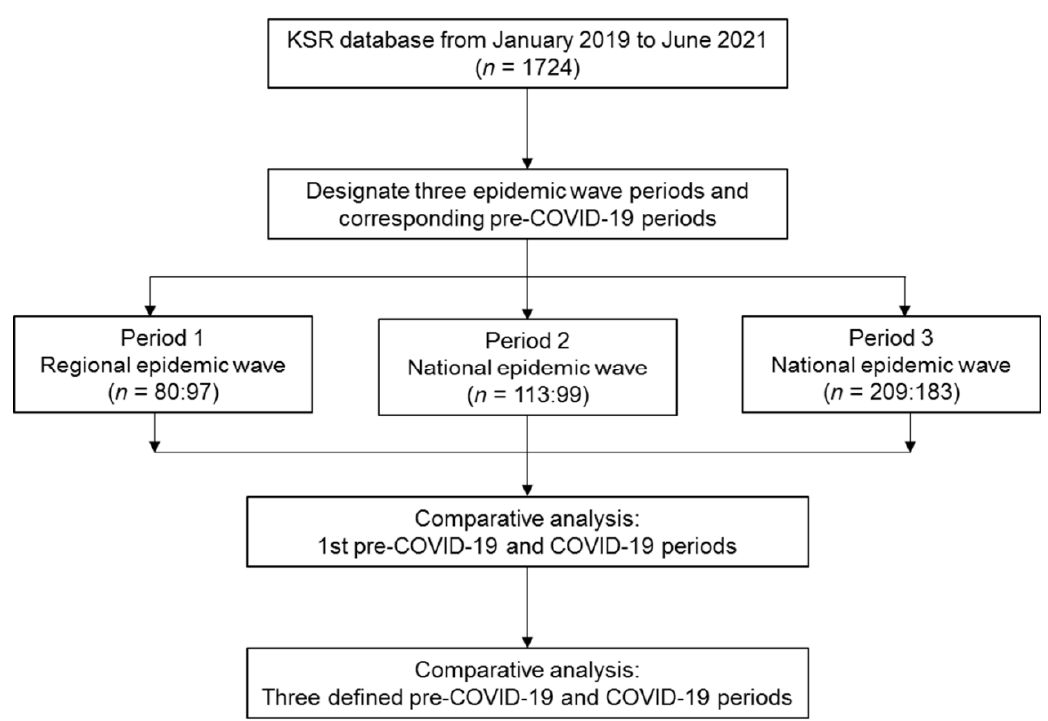
Figure 2. Flowchart of this study. KSR—Korean Stroke Registry; COVID-19—coronavirus disease. The exclusion criteria for this study were: (1) patients who visited the hospital seven days or more after the onset of stroke; (2) patients with missing data; and (3) patients hospitalized for acute stroke but not enrolled in the KSR (overall acceptance rate: 94.9%).